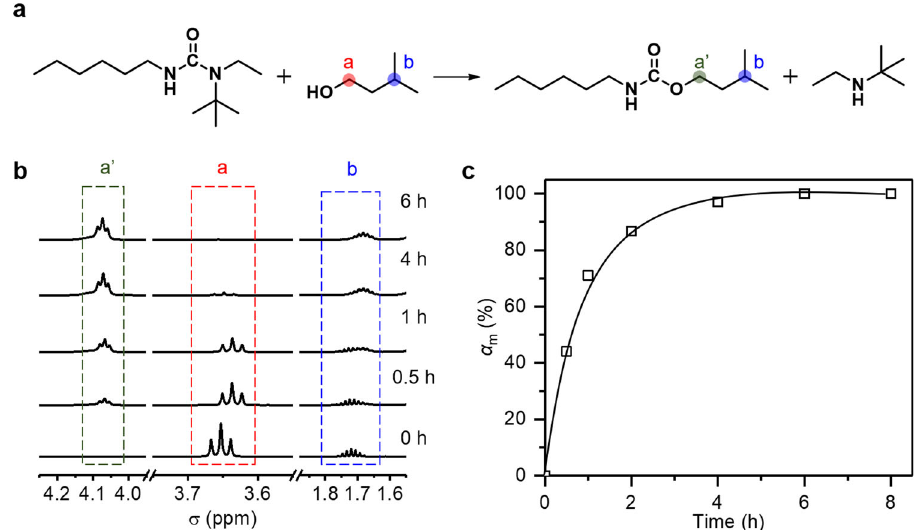
Fig. 2 | Model compound study of n-hexyl-n-tert-butylethyl-urea and 3-methyl − 1-butanol. a Heterolytic exchange chemistry that transforms hindered urea into urethane. b 1 H NMR monitoring of the model reaction. c Kinetics of the bond conversion at